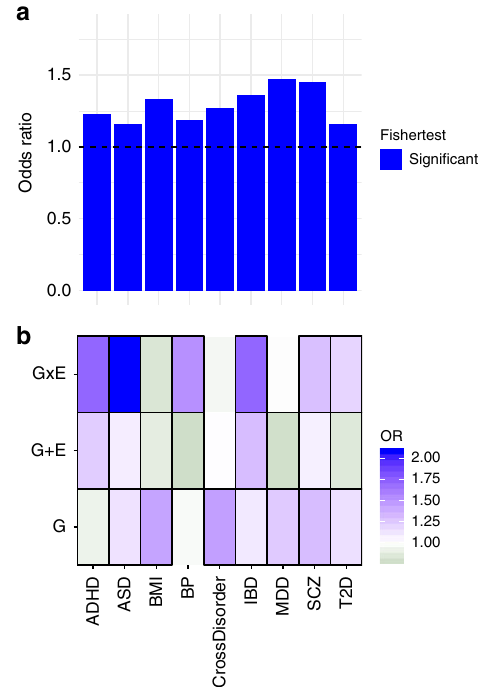
Fig. 7 Enrichment of DeepSEA variants for GWAS associations. a Enrichment for nominal signi fi cant GWAS associations for all tested DeepSEA variants and their LD proxies for GWAS for ADHD (attention- de fi cit hyperactivity disorder), ASD (autism spectrum disorder), BMI (body mass index), BP (bipolar disorder), CrossDisorder, IBD (in fl ammatory bowel disease), MDD (major depressive disorder), SCZ (schizophrenia) and T2D (Type 2 diabetes). The Y -axis denotes the fold enrichment with regard to non-DeepSEAvariants. Blue bars indicate signi fi cant enrichment/ depletion based on Fisher-tests. b Enrichment for nominal signi fi cant GWAS hits for DeepSEA variants and their LD proxies involved in best models with G, G + E or GxE as compared to all tested DeepSEA variants. Green colour indicates depletion, red colour indicates enrichment. Thick black lines around the rectangles indicate signi fi cant enrichment/depletion based on Fisher-tests